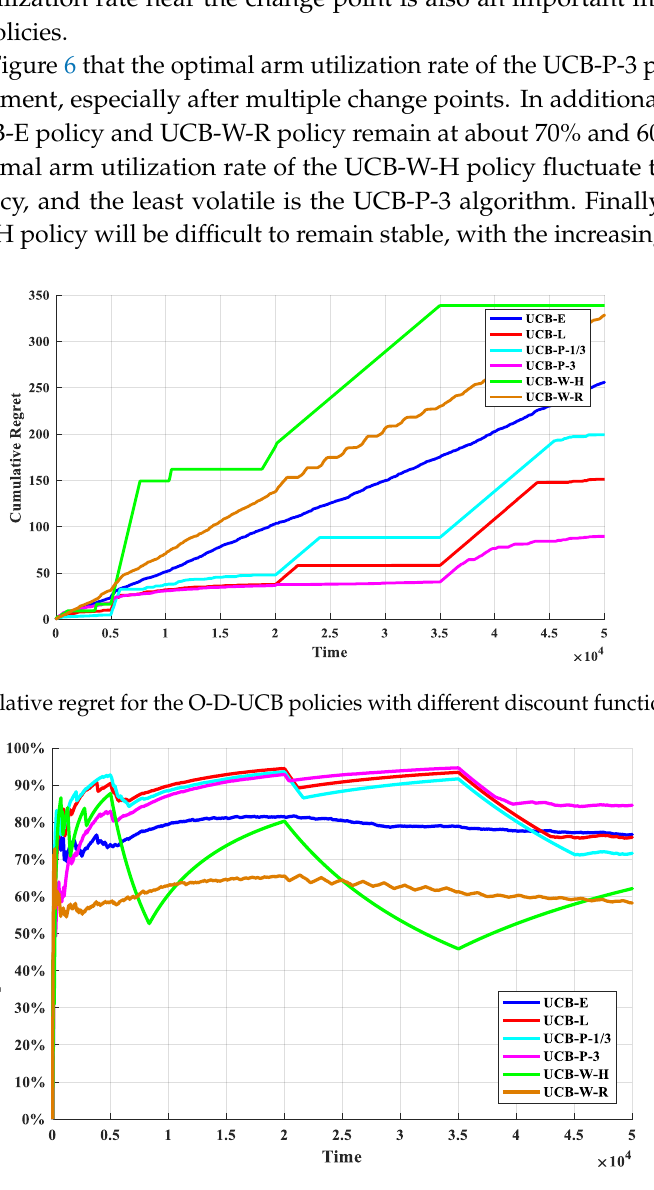
Figure 6. The optimal arm utilization rate for the O-D-UCB policies with different discount functions in dataset b.